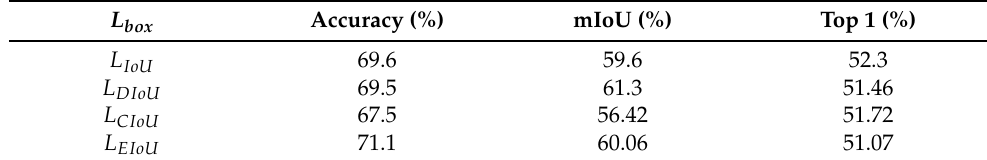
Table 8. Comparison of L box with different IoU losses.